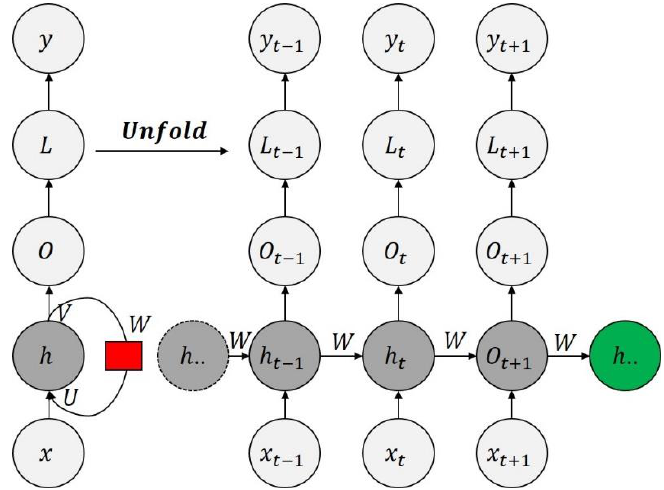
Figure 3. General architecture of recurrent neural network (RNN) .